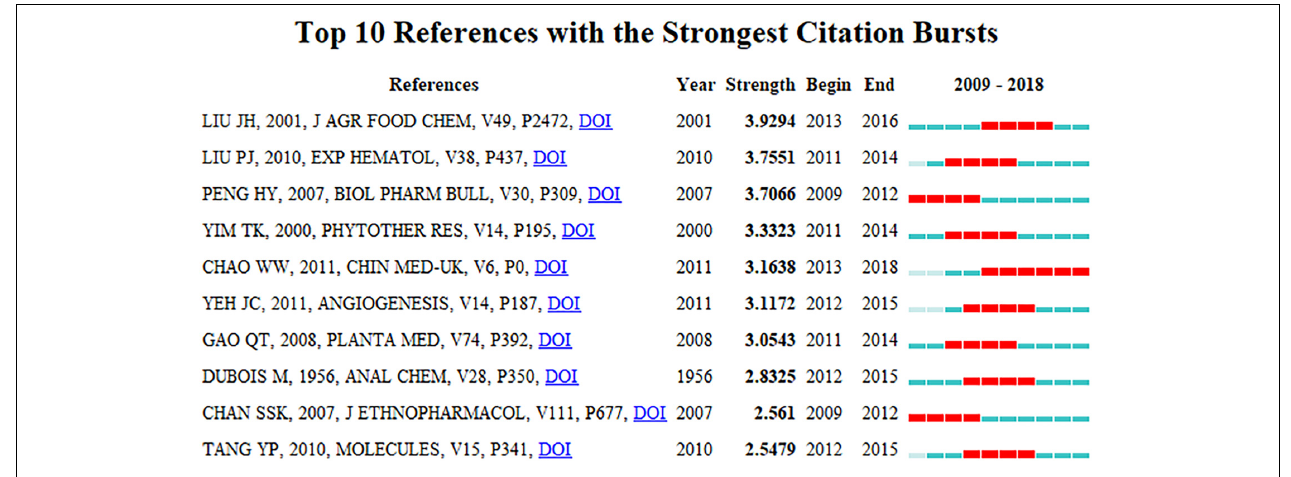
FIGURE 5 | The top 10 Angelica sinensis articles with the strongest strength citation